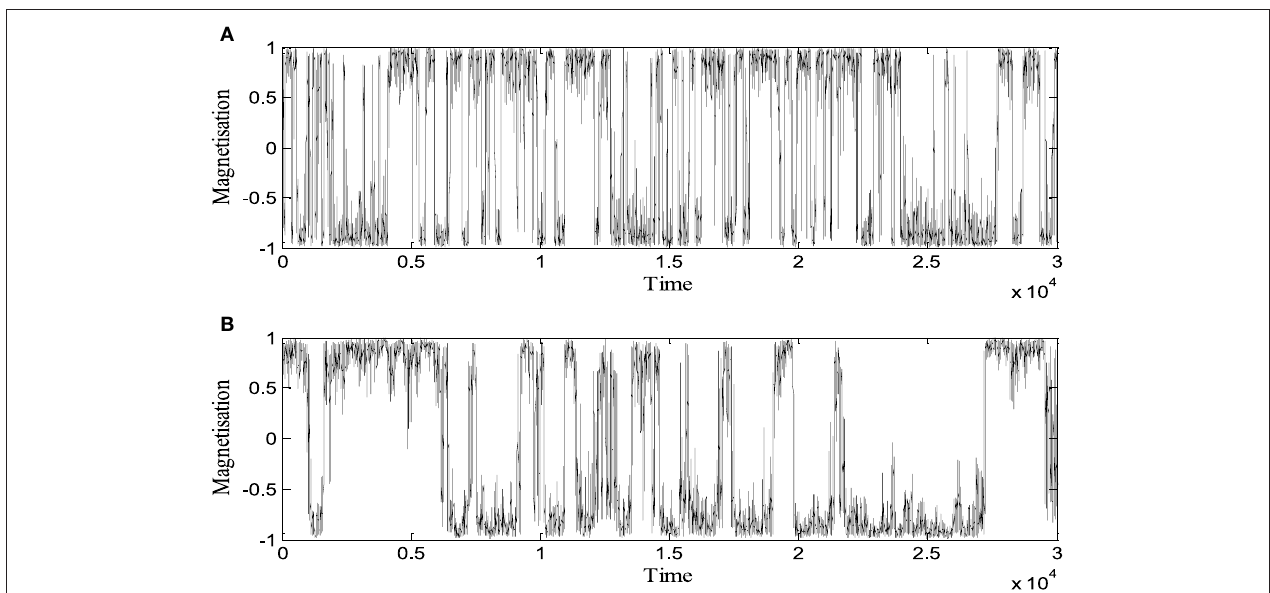
FIGURE 3 | Time series of magnetization generated by (A) SCS model and (B) LCS model. Here are shown values for the first 30,000 time units (adapted from Duka et al.,